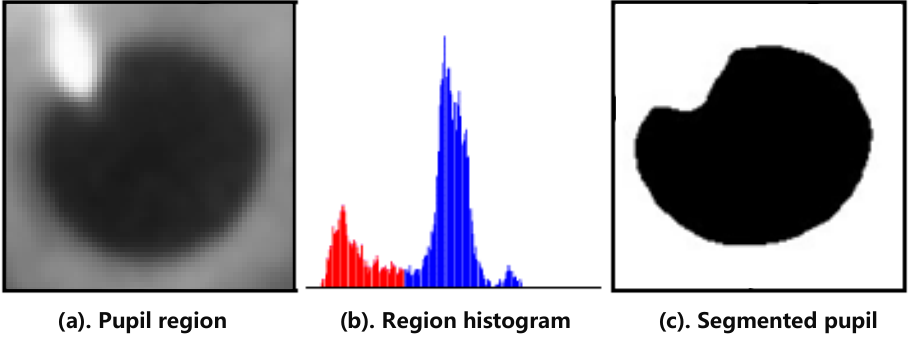
Figure 17. Binarization image representation using K-means [24,25].